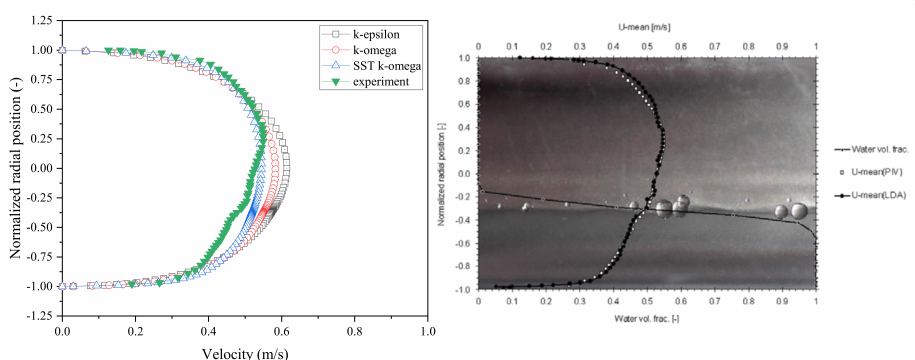
Figure 9. Velocity distribution at pipe centerline under different turbulence models given mixed velocity 0.43 m/s and water cut 0.25 [41].